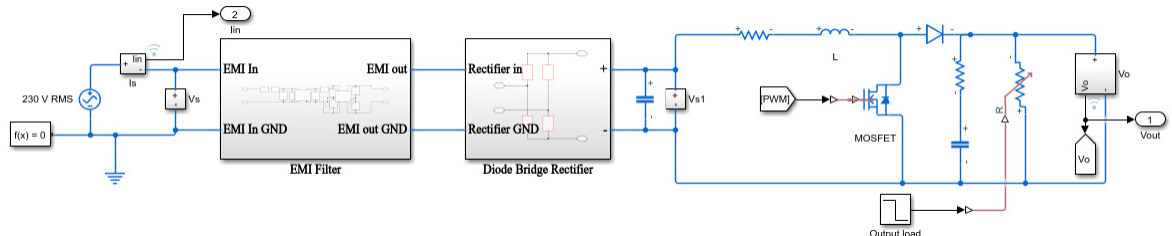
Figure 8. Simulink model of the boost PFC converter without control loop.